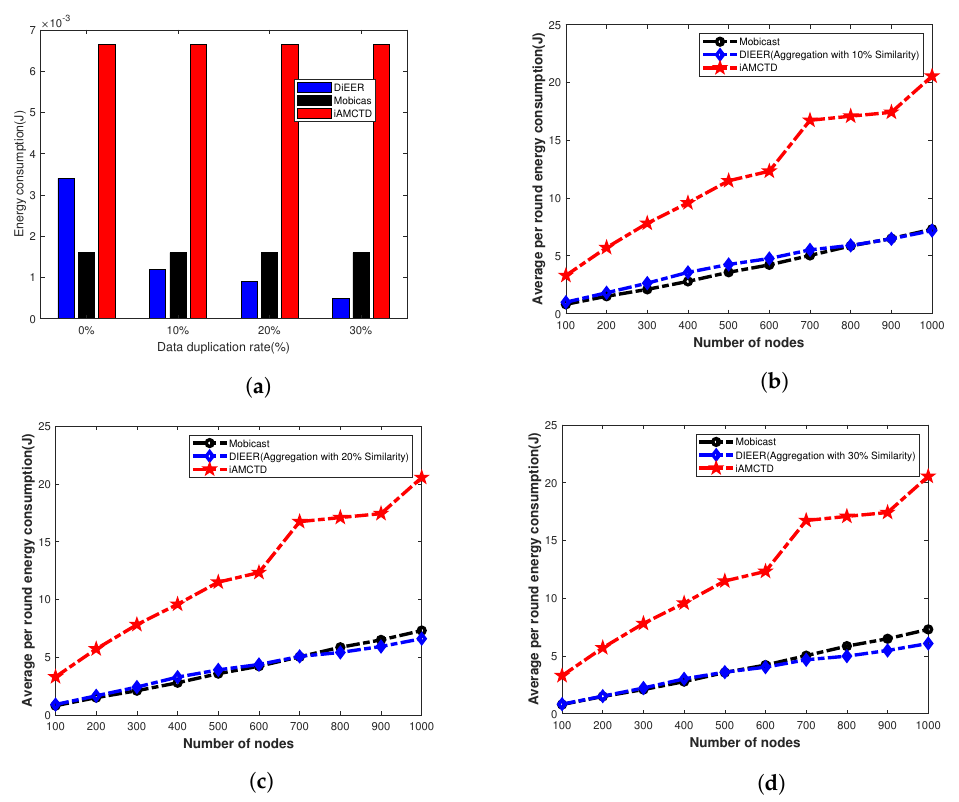
Figure 10. Energy-consumption analysis. ( a ) Energy-consumption analysis with varying data duplication rate; ( b ) Energy consumption with 10% data duplication; ( c ) Energy consumption with 20% data duplication; ( d ) Energy consumption with 30% data